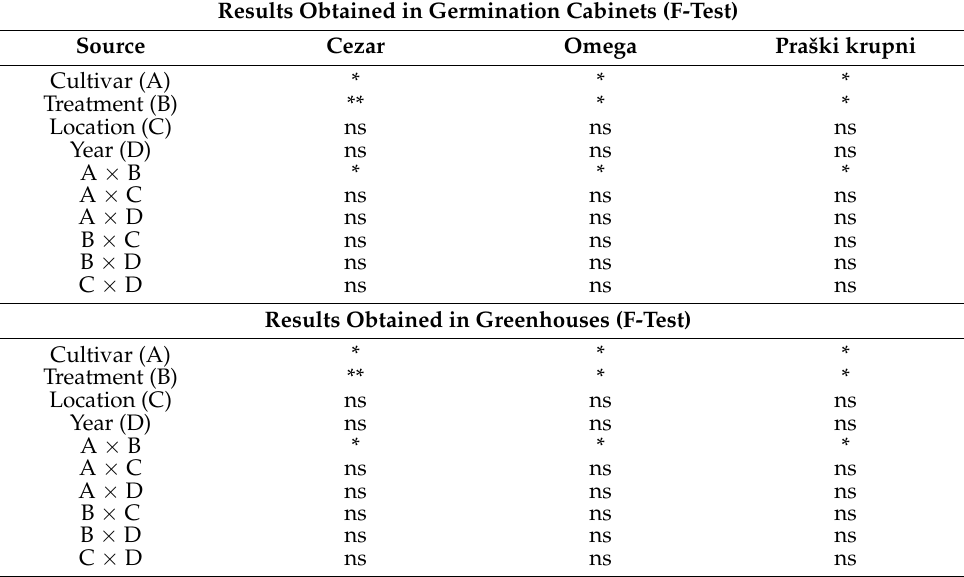
Table 8. Factors on germination and the seedling growth after treatments applied to celeriac